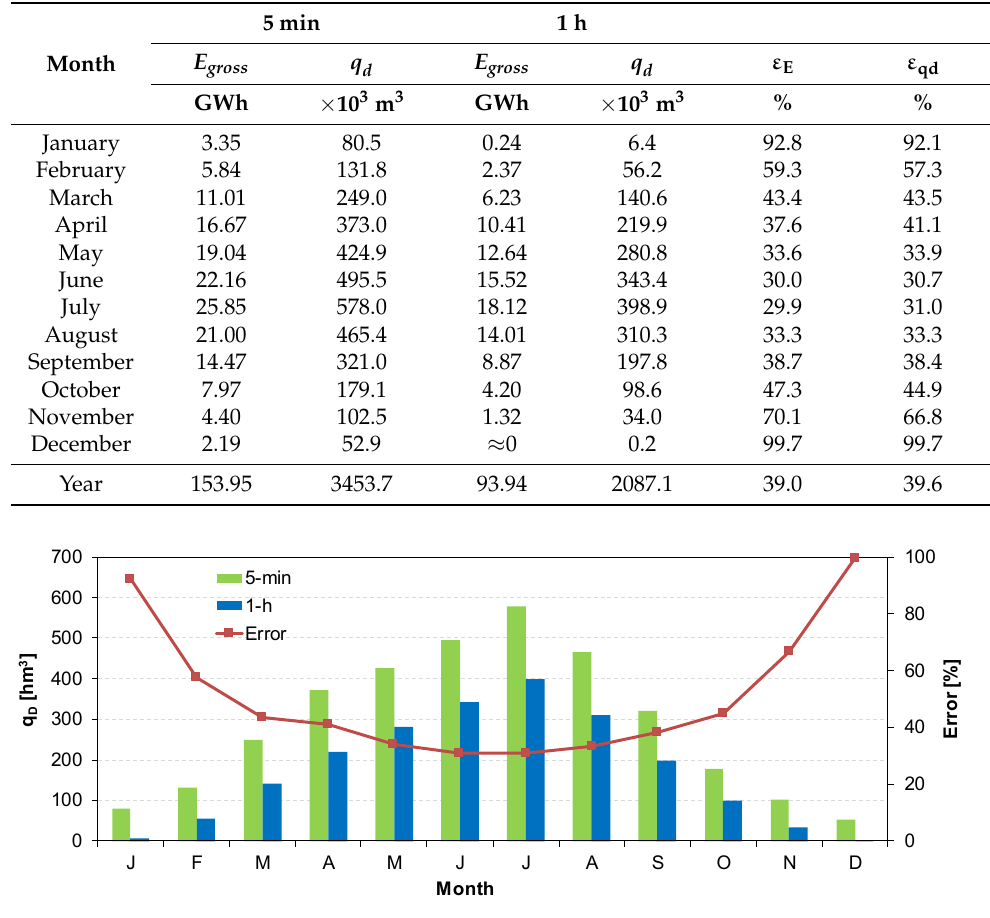
Figure 10. Yearly production of freshwater obtained with 5 min and 1 h simulation time steps.